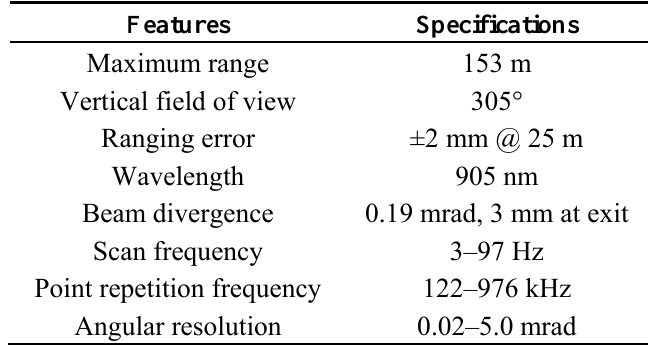
Table 3. The technical specifications of the laser scanner (FARO Focus3D 120S a